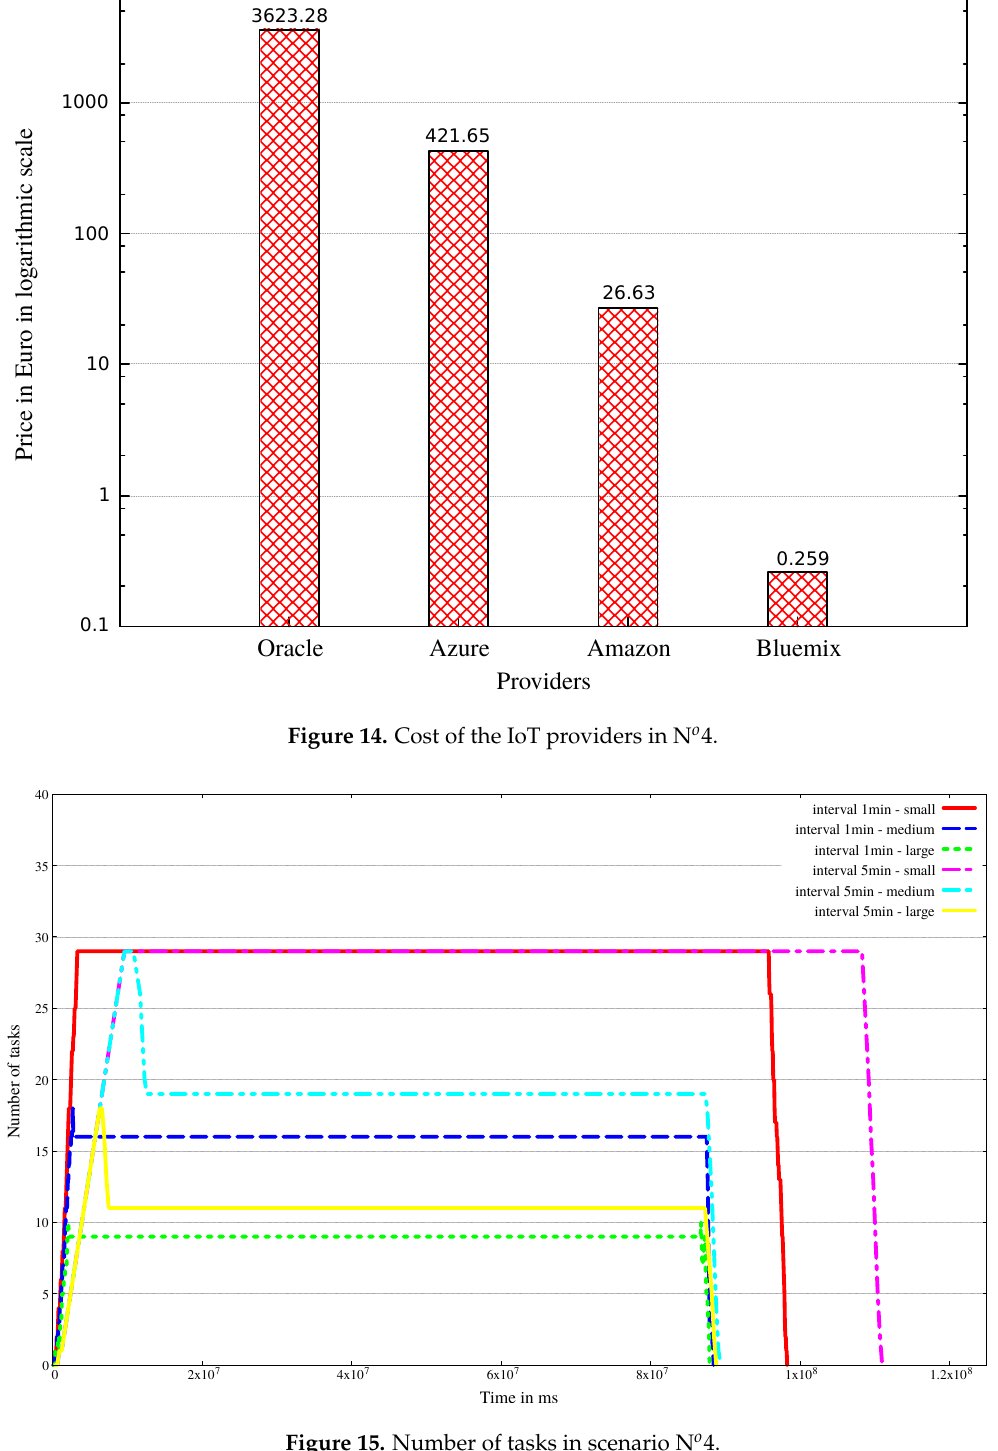
Figure 15. Number of tasks in scenario N o